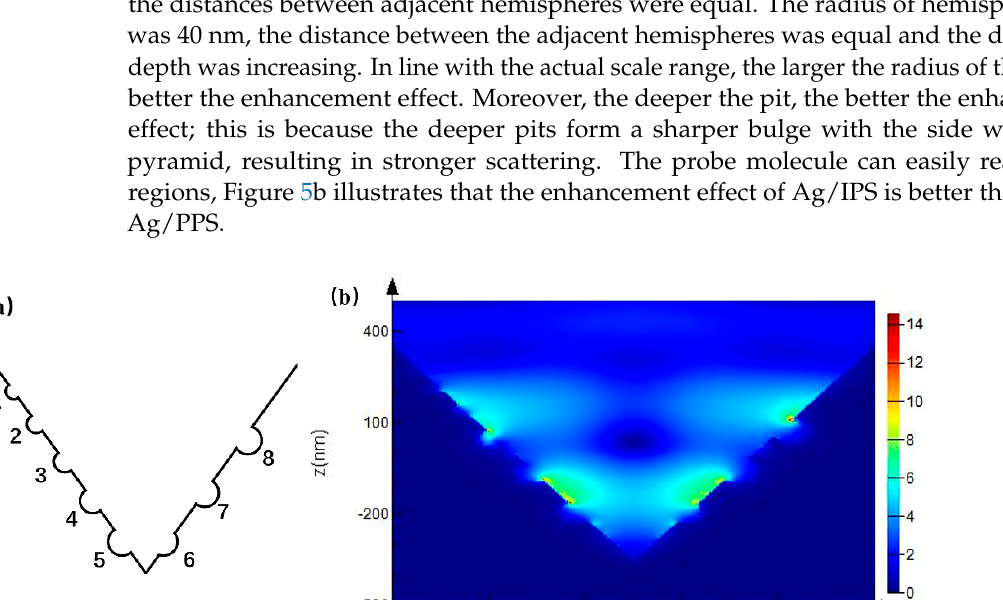
Figure 6. Electric field distribution diagram of Ag/IPS with pits in the y-z plane. 3.2. Raman Spectra of R6G on Pyramidal Sensors In order to make the Raman spectra of probe molecules of all concentrations under the same laser power compare with the threshold range of the spectrum software, the laser defocusing mode with a laser spot of 2~3 μ m in diameter was used to make the laser focus on another plane outside the surface of the measured object, so as to reduce the excessive strong spectrum of the measured molecules with high concentration. To study the SERS sensitivity of the improved structure, the spectra of four substrates were measured using R6G as a probe molecule, with the same concentration of 10 (cid:2879)(cid:2874) M, Figure 7 shows the SERS sensitivity measurement results obtained from four SERS sub- strates in R6G. The results show that all four substrates had a SERS effect. The enhance- ment effect of Ag/IPS was far greater than that of Ag/PPS, which was consistent with the